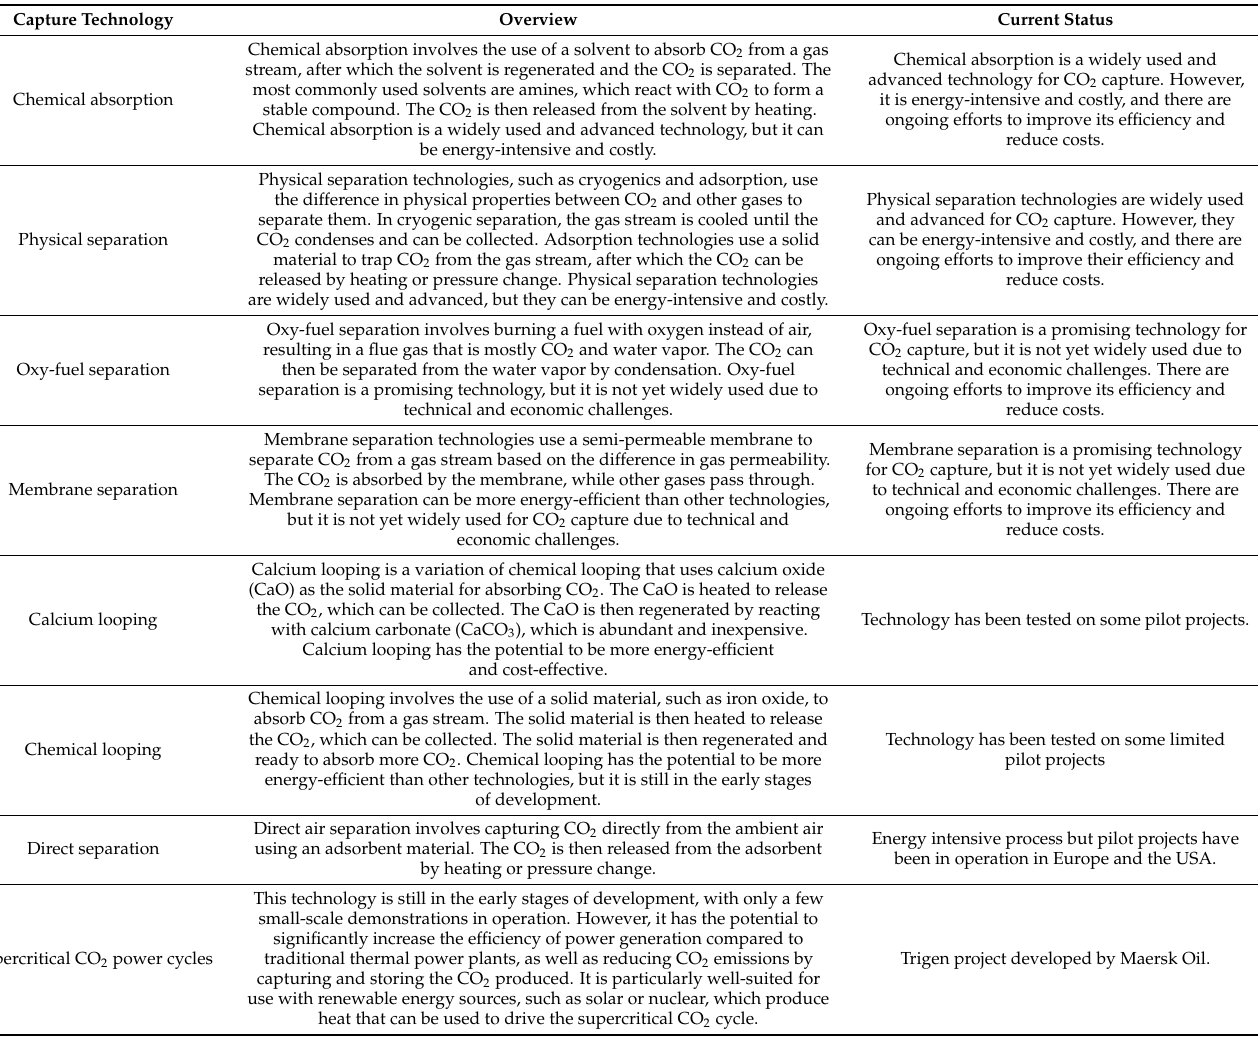
Table 1. CCUS capture